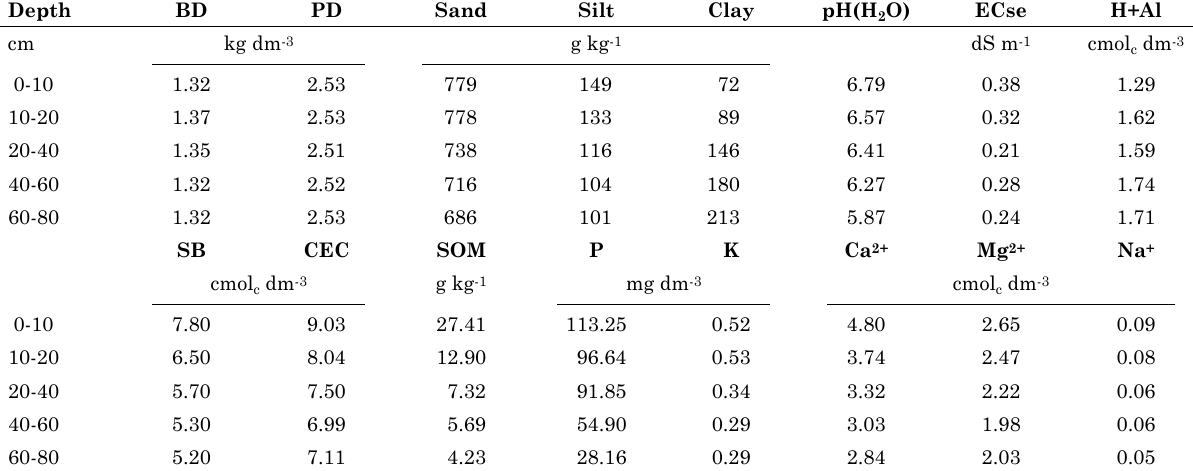
Table 1. Physical and chemical characteristics of the Ultisol cultivated with grapevines under different irrigation strategies